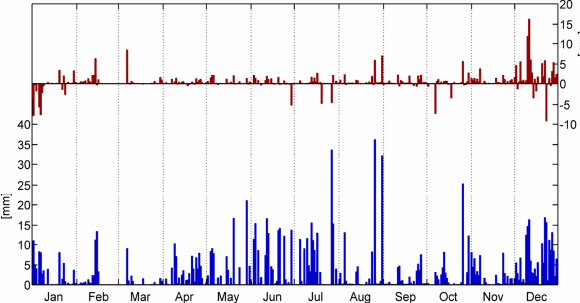
Figure 4. Daily precipitation sums of tipping bucket (blue) and dif- ference in precipitation measurements between lysimeter and TB (red) at the Rollesbroich study site for